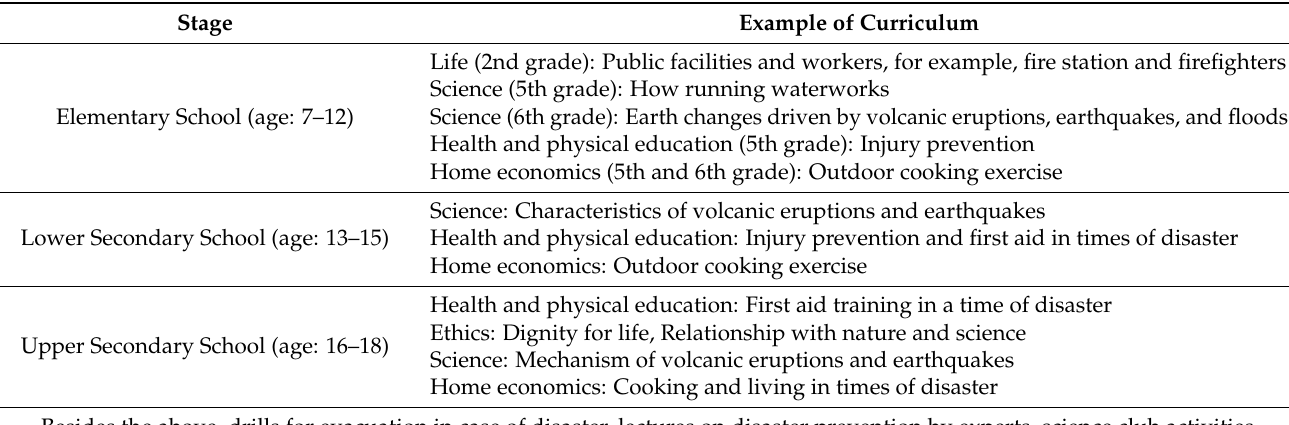
Table 3. Synthesis of sample activities for disaster risk reduction in the school curriculum, according to the MEXT. Stage Example of